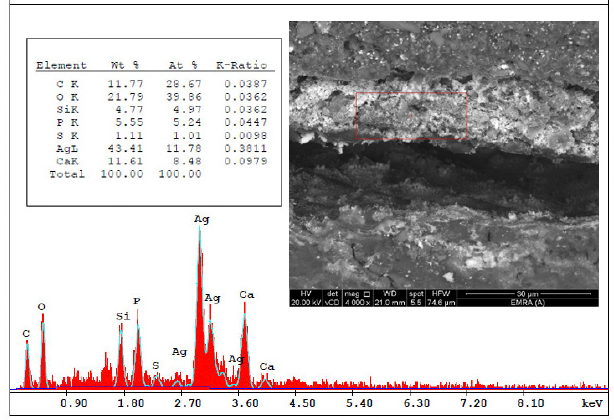
Figure 4. Selected scanning electron microscopy/energy- dispersive X-ray analysis at the resin-superficial dentin interface in teeth treated with self-adhering resin composite. Image representative of 8